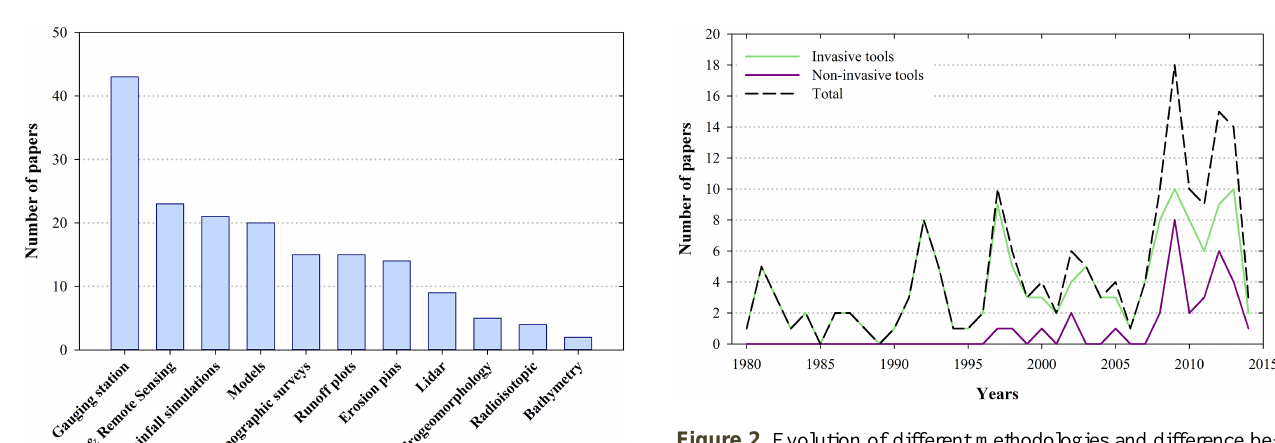
Figure 2. Evolution of different methodologies and difference be- tween invasive and non-invasive